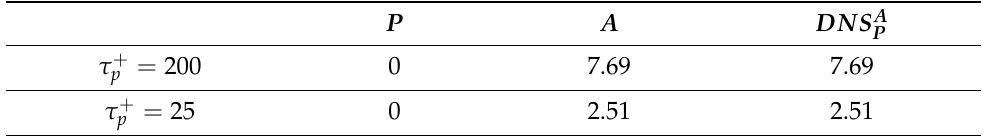
Table 4. Relative error of prediction of peak values and positions of rms + w (in percentage). Nomen- clature: P , Position; A , Amplitude; DNS A , DNS Peak P